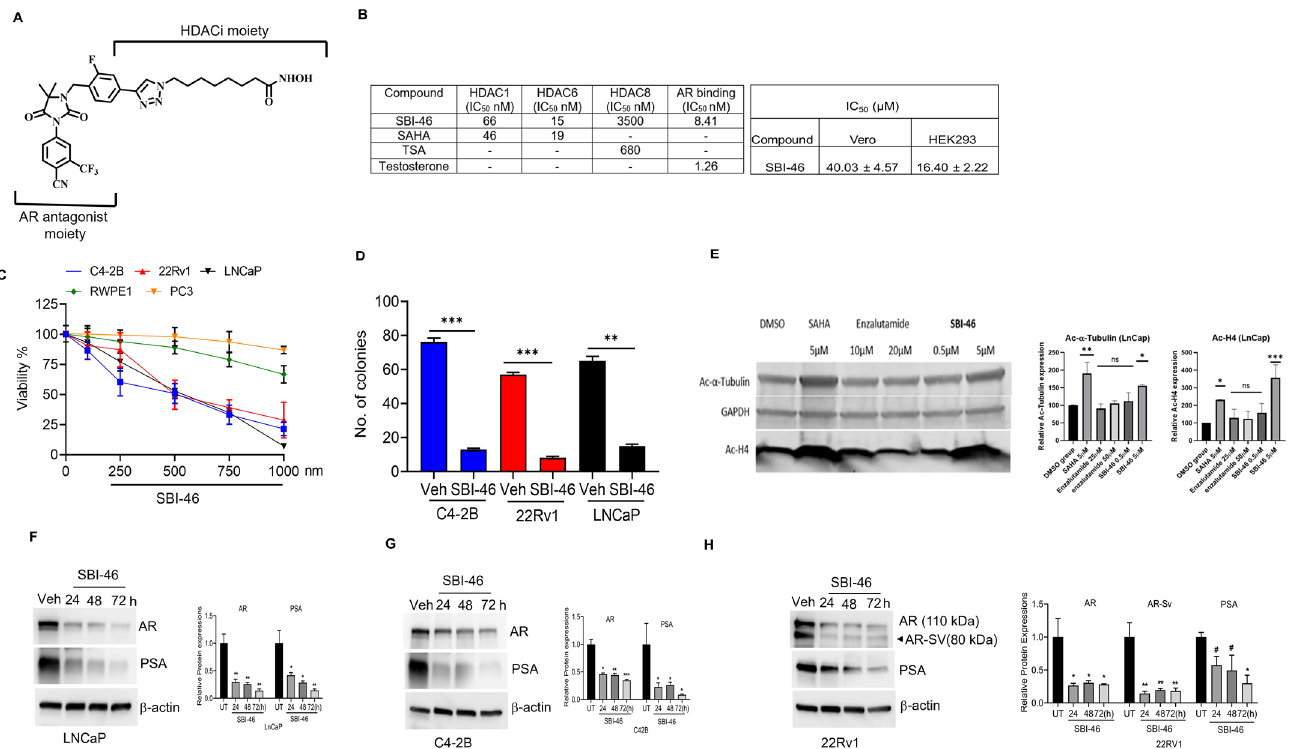
Figure 1. SBI-46 demonstrates on-target effects and inhibits CRPC cell proliferation, growth, and AR and AR-SV expressions. ( A ) Structure of SBI-46. ( B ) HDAC inhibition activities and AR binding affinity of SBI-46. SAHA and TSA were used as controls for HDAC inhibition, while testosterone was used as a control for AR binding and effect of SBI-46 on HEK-293 and VERO cells. ( C ) Effects of SBI-46 treatments (24 h) on the proliferation of CRPC (LNCaP, C4-2B, and 22Rv1) PC3 and RWPE-1 cells. ( D ) LNCaP, C4-2B, and 22Rv1 were treated with SBI-46, and a soft agar colony formation assay was performed. Colonies were counted, and results are presented as means ± SD of experiments performed in triplicate. One-way ANOVA with multiple comparison tests was used to calculate the statistical significance between different experimental groups. ** p < 0.01 and *** p < 0.001. ( E ) Western blotting analysis of SBI-46 treated or vehicle-treated LNCaP lysates revealed that SBI-46, analogously to SAHA, upregulates the levels of acetylated tubulin and H4. Quantification bars show mean plus standard deviation; ordinary one-way ANOVA compared with the control group, * p < 0.0332; ** p < 0.0021; *** p < 0.0002). ( F – H ) Western blotting analysis of SBI-46-treated or vehicle-treated PCa lysates for AR, AR-SV, and PSA expression. Values, mean ± SD. * p < 0.05 and ** p < 0.01. The uncropped blots are shown in the Supplemental Materials. #, not